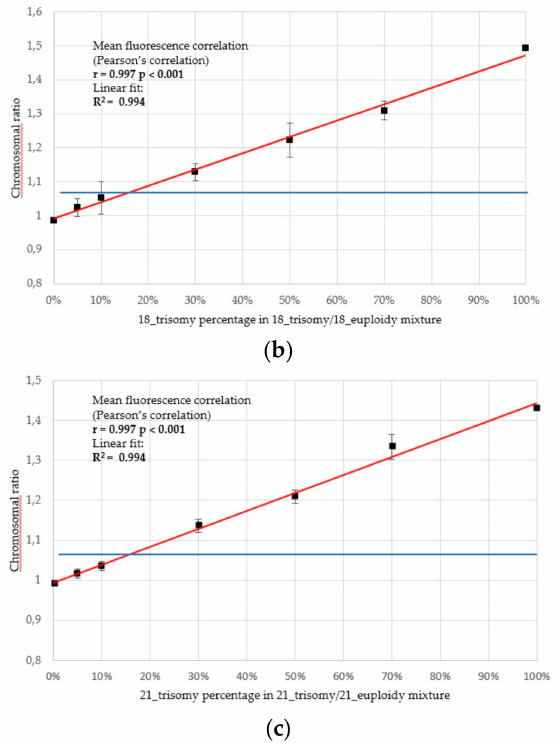
Figure 5. Scatter plots of serial dilutions for aneuploidies. Mixtures containing 0%, 5%, 10%, 30%, 50%, 70% and 100% of trisomies were performed. Scatter plots representing ( a ) slope ratios in 13 trisomy; ( b ) slope ratios in 18 trisomy and ( c ) slope ratios in 21 trisomy as a function of the percentage of the respective aneuploidies in the aneuploid / euploid mixture. Individual samples were analyzed in technical duplicates and averaged. The Pearson’s correlation was calculated. The red line represents an estimated linear fit (with a respective R 2 value). The blue line marks a suggested cut-o ff point for aneuploidies detection (estimation based on Figure 3 on the basis of maximum values observed in euploid samples: 1.145 for T13, 1.068 for T21 and 1.077 for